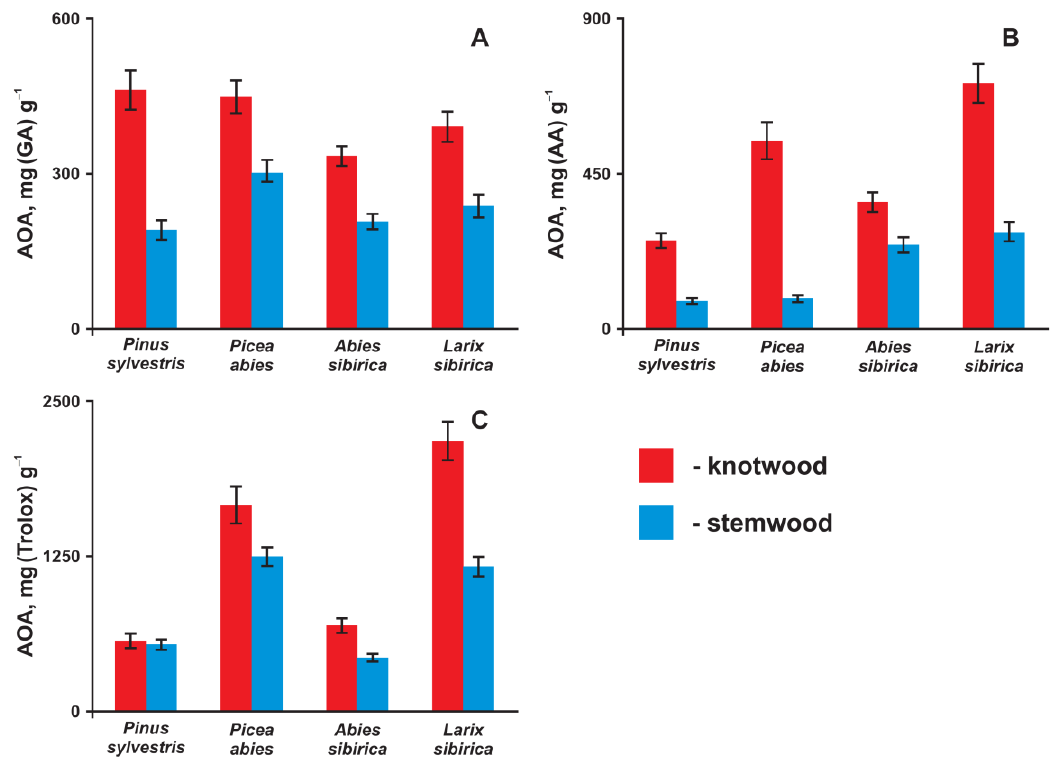
Figure 1. Antioxidant activity (AOA) of the knotwood and stemwood extractives determined in amperometric ( A ), DPPH ( B ), and PCL ( C ) assays. The AOA values are represented in gallic acid (GA), ascorbic acid (AA), and Trolox equivalents, respectively.